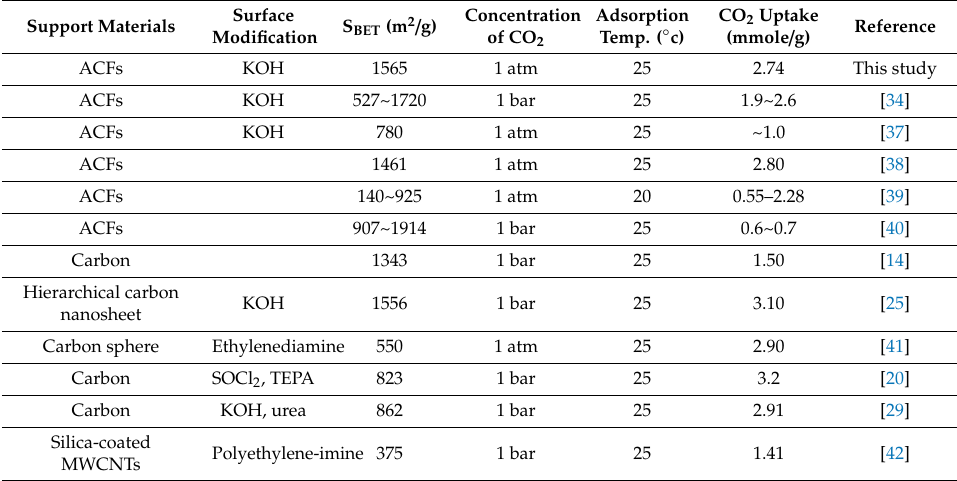
Figure 7. Correlation of equilibrium CO 2 uptake at CO 2 = 0.15 atm and 25 ◦ C with the ( a ) BET surface area (S BET ) and micropore area (S mi ); ( b ) micropore volume (V mi ) and ultramicropore volume (V ultra ); ( c ) surface N and O content; ( d ) NO 2 (%) in N-groups; ( e ) percentage of O-functionalities. Table 3. Comparisons of CO 2 uptake on the adsorbents in this study with various supporting materials from the literature.